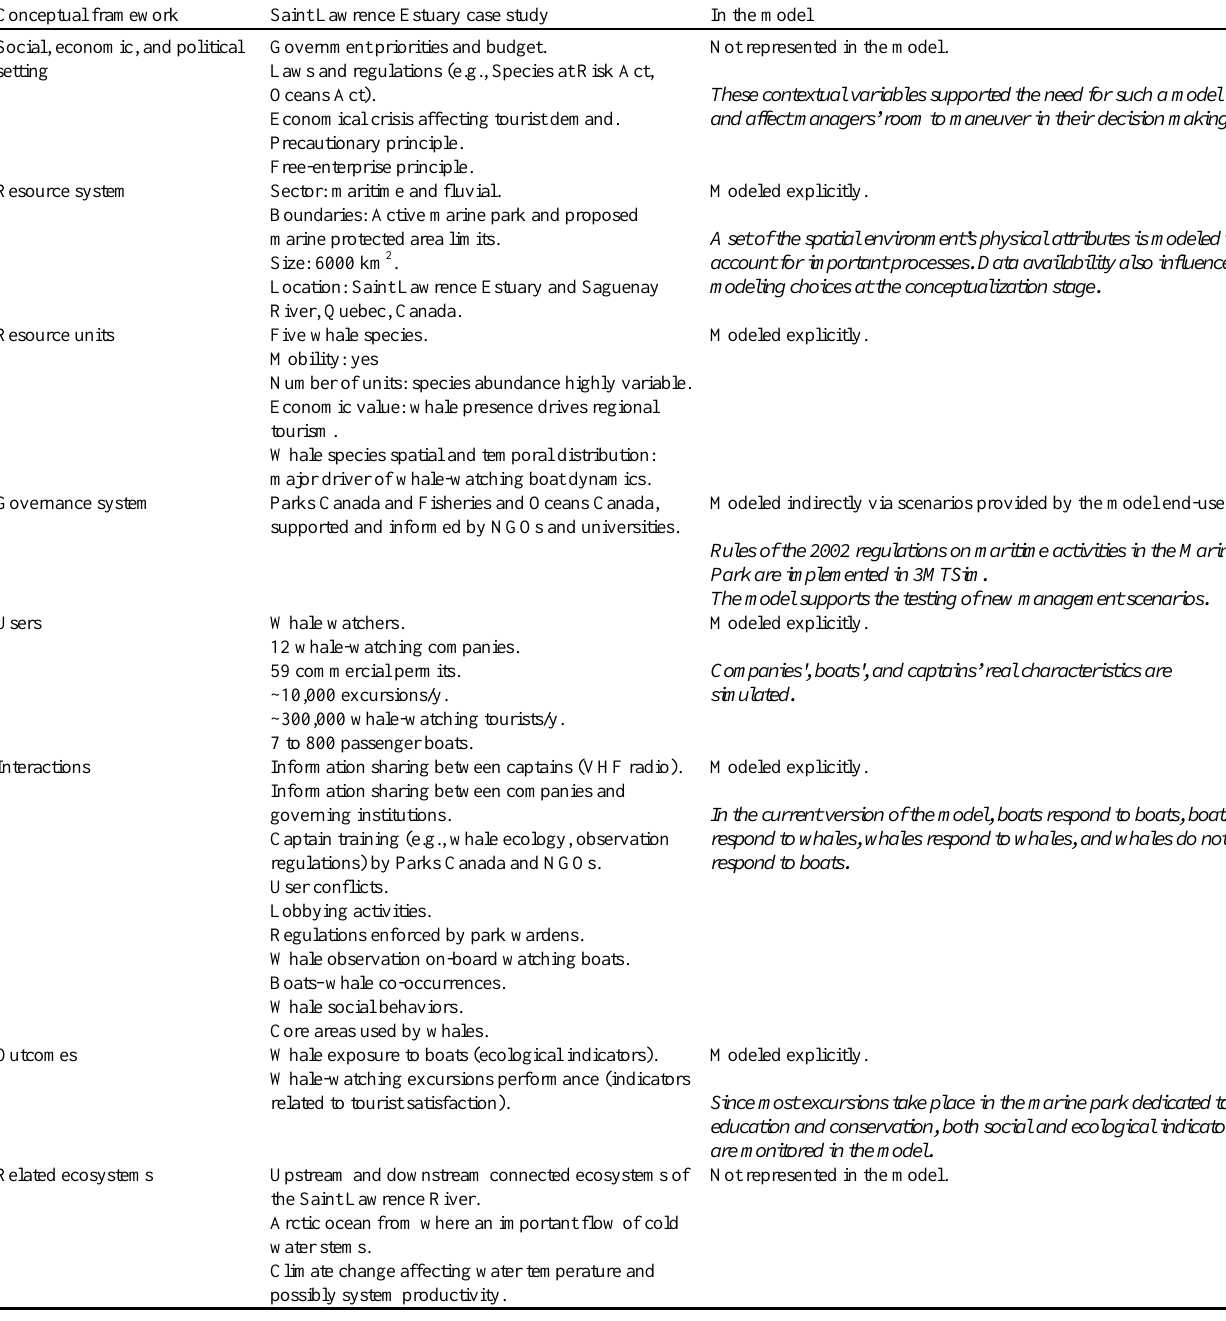
Table 2 . Conceptual framework of case study 2: Saint Lawrence Estuary, eastern